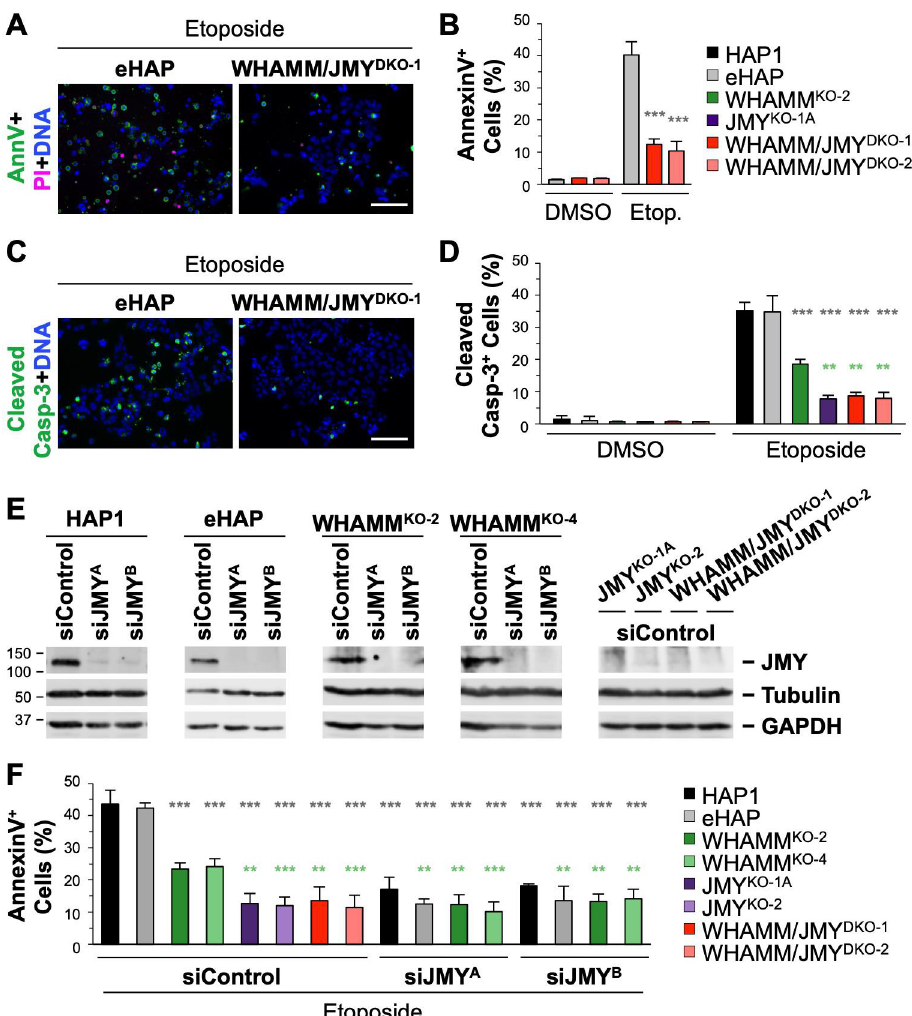
Fig 4. Deletion or depletion of JMY reduces apoptosis in WHAMM-deficient cells. (A) eHAP and WHAMM/ JMY DKO cells were treated with DMSO or 5 μ M etoposide for 6h and stained with Alexa488-AnnV, PI, and Hoechst. Scale bars, 100 μ m. (B) The % of AnnV-positive cells was calculated, and each bar represents the mean ± SD from 3 experiments (n = 3,035–7,080 cells per bar). (C) eHAP and WHAMM/JMY DKO cells were treated with DMSO or etoposide before being fixed and stained with an antibody that recognizes caspase-3 cleaved at Asp175 (Cleaved Casp- 3; green) and DAPI (DNA, blue). (D) The % of cleaved caspase-3-positive cells was calculated, and each bar represents the mean ± SD from 3 experiments (n = 2,962–7,844 cells per bar). Gray significance stars refer to comparisons to the parental samples and green significance stars refer to comparisons to the WHAMM KO samples. (E) HAP1, eHAP, and WHAMM KO cells were treated with control siRNAs or independent siRNAs for the JMY gene, while JMY KO and WHAMM/JMY DKO cell lines were treated with control siRNAs before immunoblotting with antibodies to JMY, tubulin, and GAPDH. (F) Etoposide-treated cells were stained with Alexa488-AnnV, PI, and Hoechst. The % of AnnV-positive cells was calculated and each bar represents the mean ± SD from 3 experiments (n = 2,485–4,596 cells per bar). Gray significance stars refer to comparisons to the parental siControl samples and green significance stars refer to comparisons to the WHAMM KO siControl samples. �� p < 0.01; ��� p < 0.001 (ANOVA, Tukey post-hoc tests).